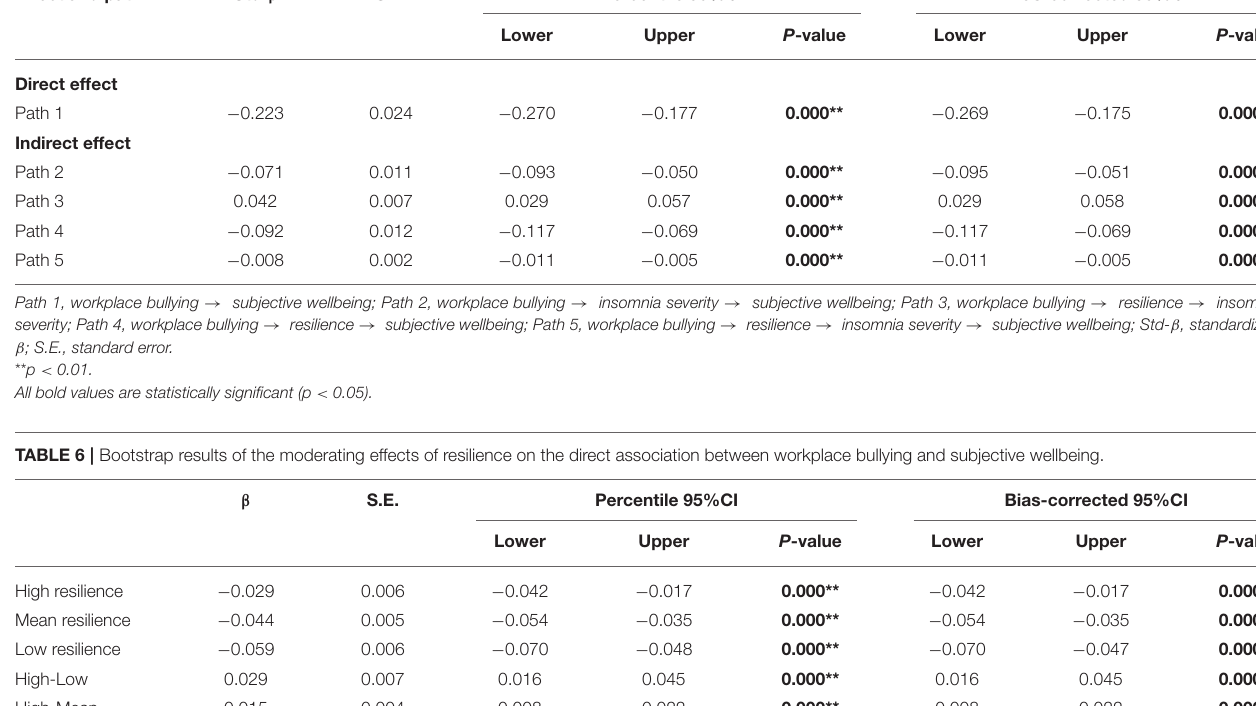
TABLE 5 | Bootstrap results of direct and indirect effects between workplace bullying and subjective wellbeing. Effect and path